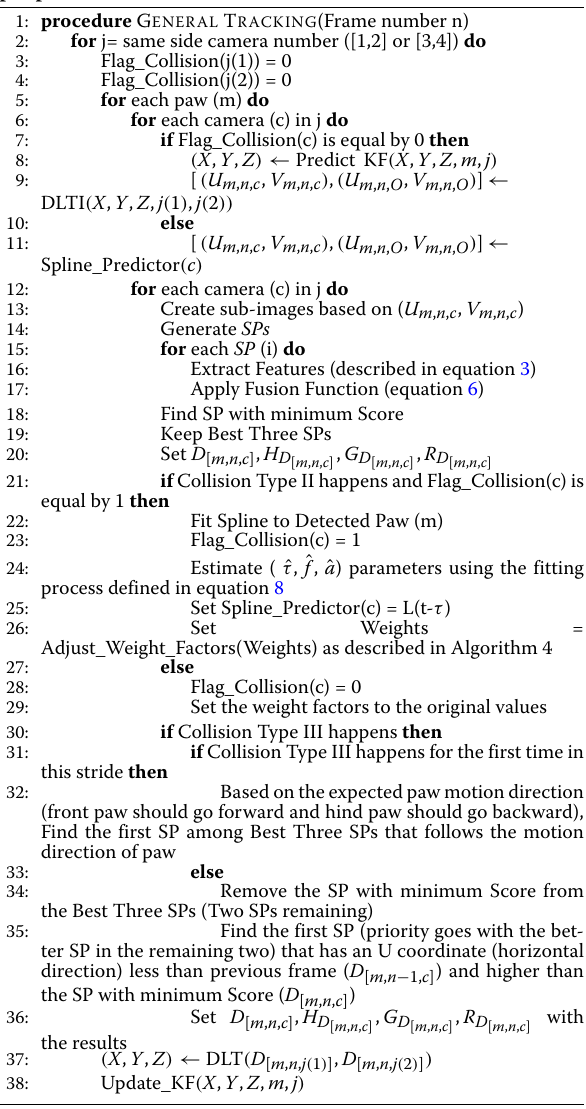
Algorithm 3 The presented algorithm includes general tracker. The variables are defined in Algorithm 1. In addi- tion, L is a symbol for the spline, defined in equation 7. Flag_Collision is a flag to keep the collision event condi- ˆ f , and ˆ a are tion (if it happens or not). The variables, ˆ τ , the time shift, “frequency of paw locomotion,” and “ampli- tude of paw locomotion,” respectively. Last but not least, O shows that we have a pair of image planes, but we process the cameras in 2D separately using DLTI function. DLT and DLTI use the coefficients calculated in equation 1. In other words, O has the value which is the j vector but not assigned as the value of c . The general tracker uses the pair of cameras located on a same side ( j ) and DLTI to map the predicted 3D coordinates of KF to provide the window in 2D image planes. However, if the collision type II happened, it uses the Spline_Predictor vector for this purpose.